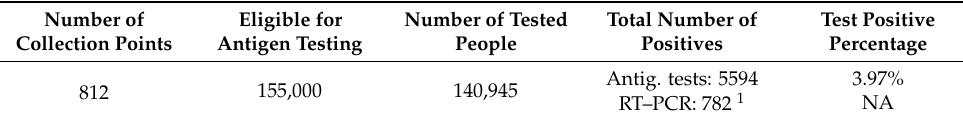
Table 2. Summary of trial testing (23–25 October 2020) [20].